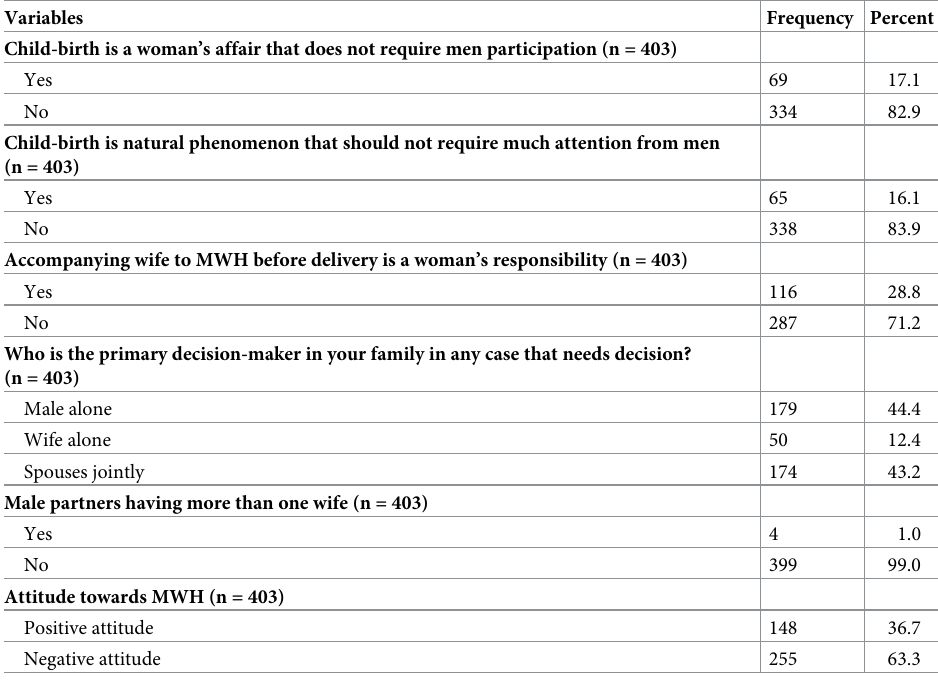
Table 3. Men’s gender thinking and attitude towards MWH in North Achefer district, 2018.